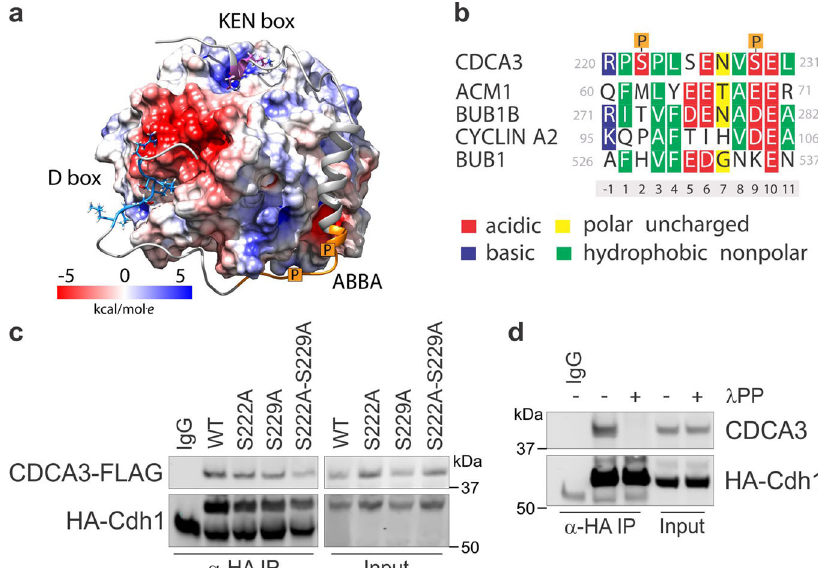
Fig. 4 Phosphorylation of CDCA3 promotes an interaction with Cdh1. a Molecular simulations of CDCA3 C-terminal region (Ser193-Glu267) with Cdh1 highlighting contribution of CDCA3 phosphorylation to an interaction with Cdh1. CDCA3 D-box, KEN box and phosphorylation sites (in orange) indicated. Lower, colour scale indicating the Columbic electrostatic potential for the entire surface of Cdh1. b Sequence alignment (upper) of CDCA3 region containing phosphorylated Ser222 and Ser229 with characterised ABBA motif containing proteins. Numbers below the sequences indicate amino acid position with respect to the identi fi ed motif. Lower, a colour key describing the charge and hydrophobicity used to categorise residues in sequence alignment. c Immunoprecipitation analysis of ectopic HA-Cdh1 with wild-type or phosphorylation site mutants of CDCA3-FLAG expressed in H460 cells. d Immunoprecipitation analysis of ectopic HA-Cdh1 with endogenous CDCA3 from H460 cell lysates either untreated or treated with lambda phosphatase ( λ PP) to remove phosphate moieties from proteins. All in vitro experiments are representative of three independent